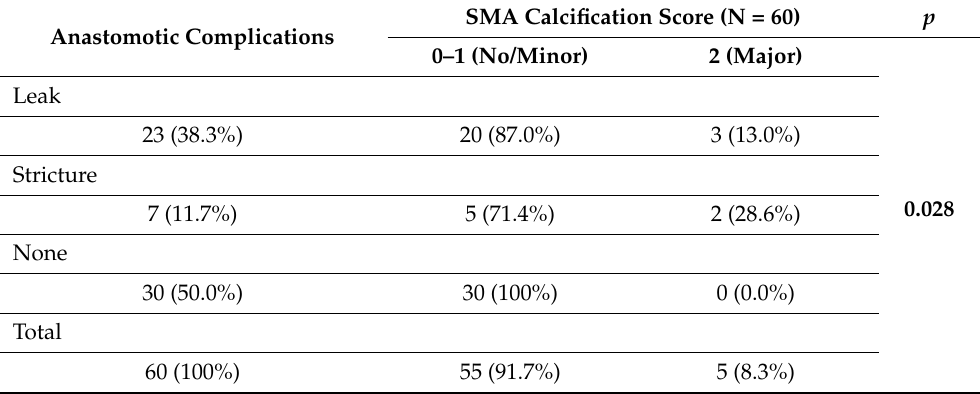
Table 4. The correlation between the kinds of anastomotic complication and the degree of SMA calcification. Anastomotic